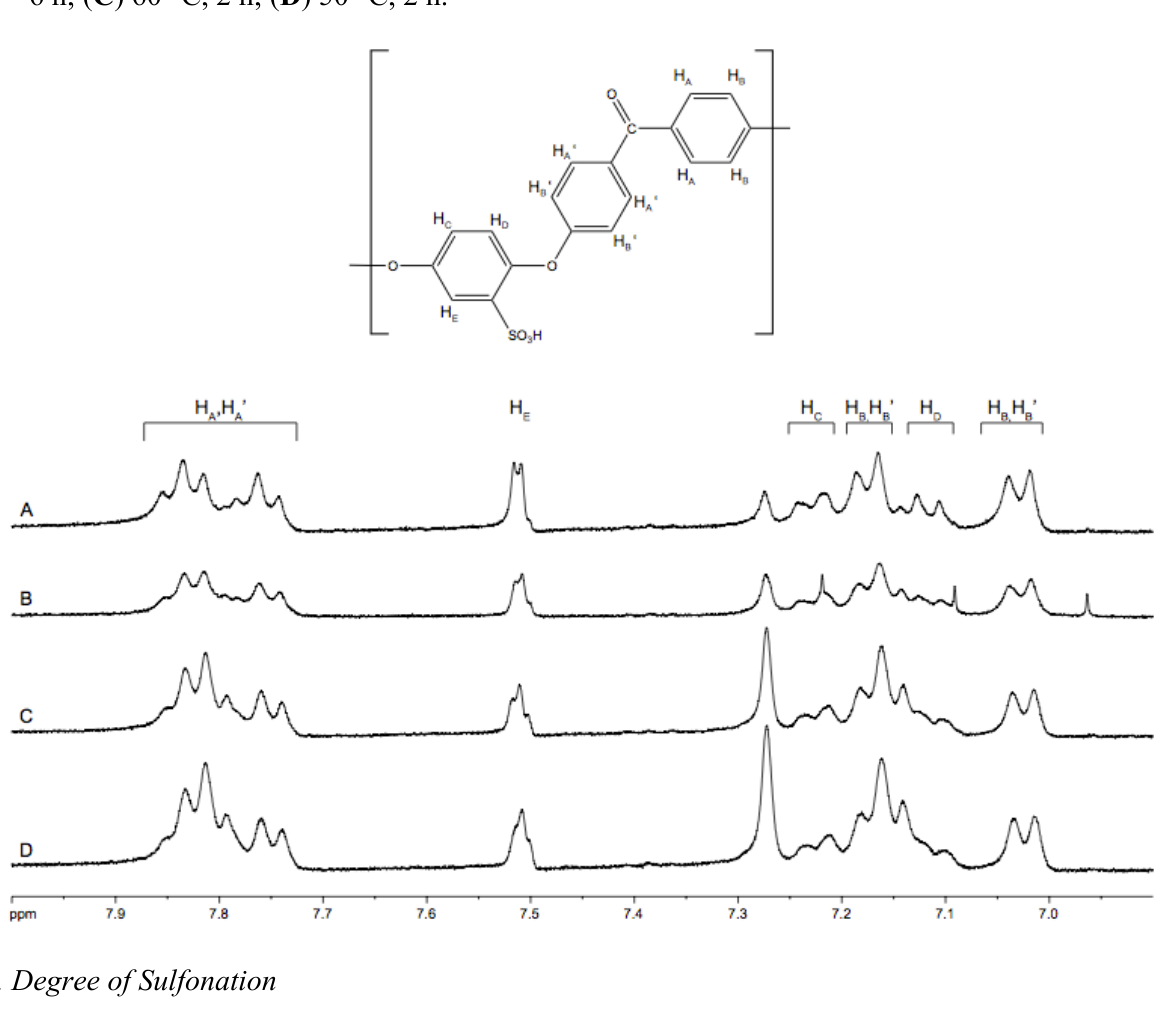
Figure 1. NMR analysis of sulfonated poly(ether ether ketone) (SPEEK) membranes produced at various sulfonation temperatures and reaction times; ( A ) 60 °C, 6 h; ( B ) 50 °C, 6 h; ( C ) 60 °C, 2 h; ( D ) 50 °C, 2